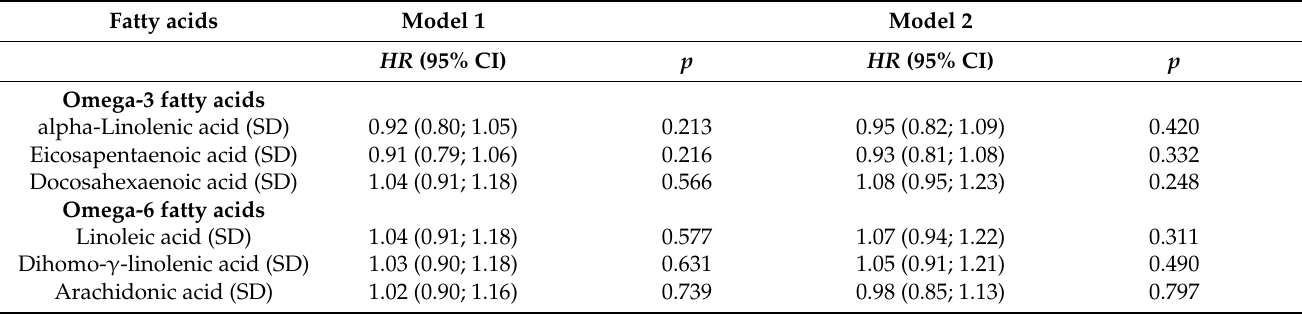
Table 5. Longitudinal associations between percentage n-3 and n-6 fatty acids in serum phospholipids and incident all-cause dementia over a 7-year follow-up period ( n = 1264).